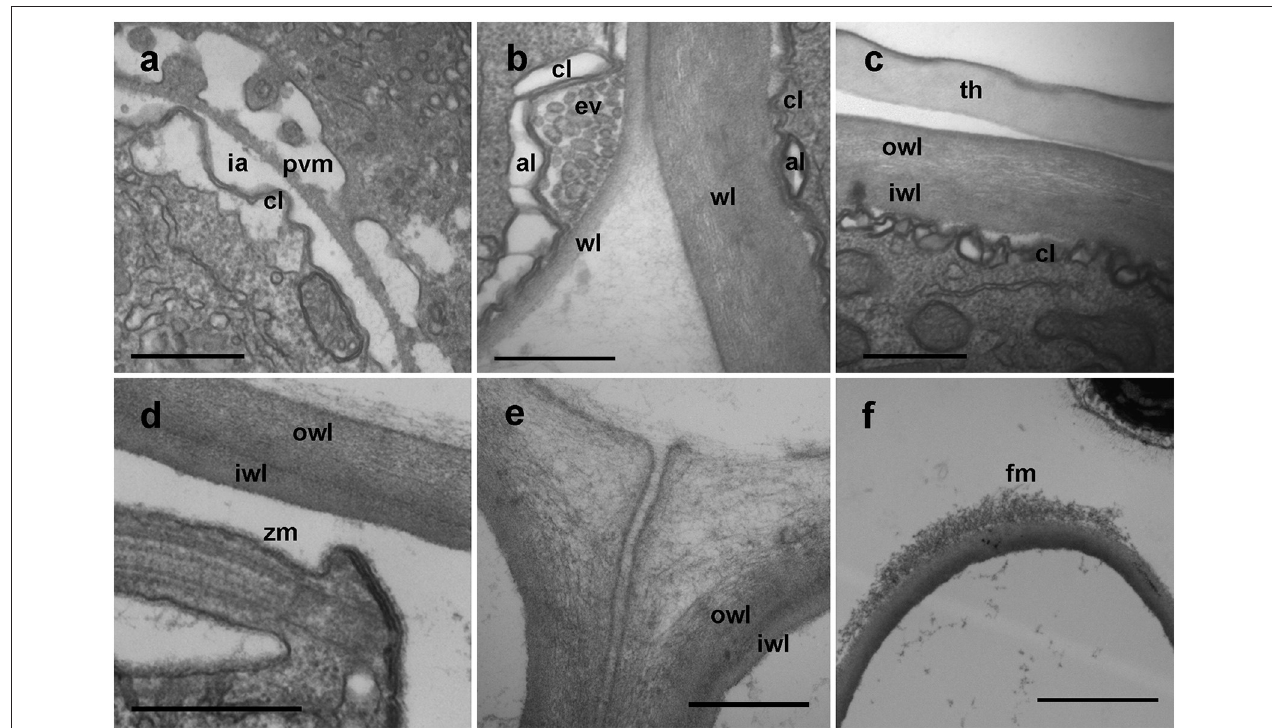
FIGURE 6 | TEM micrographs showing different stages in the development of Dinovorax pyriformis membranes. (a) Early stage of trophont development showing the parasitophorous vacuole comprising the outer parasitophorous vacuole membrane, an intermediate area and the folded parasite membrane. (b) The surface of the parasitoid membrane (cl) is folded, with endo/exocytotic vesicles along the top of the folds. (c) Late stage of the trophont, with cyst-wall already formed. (d) Cyst-wall structure of a sporocyte. (e) Cyst-wall structure of two sporocytes growing in contact. (f) Tip of the germ-tube of a sporangium. al, Alveoli; cl, convoluted membrane; ev, endocytotic vesicles; fm, fibrous material; ia, intermediate area; iwl, inner wall layer; owl, outer wall layer; pvm, parasitophorous vacuole membrane; wl, wall layer; th, dinoflagellate theca; zm, zoospore membrane. Scale bars: (a–e) = 500nm; (f) = 2 µ